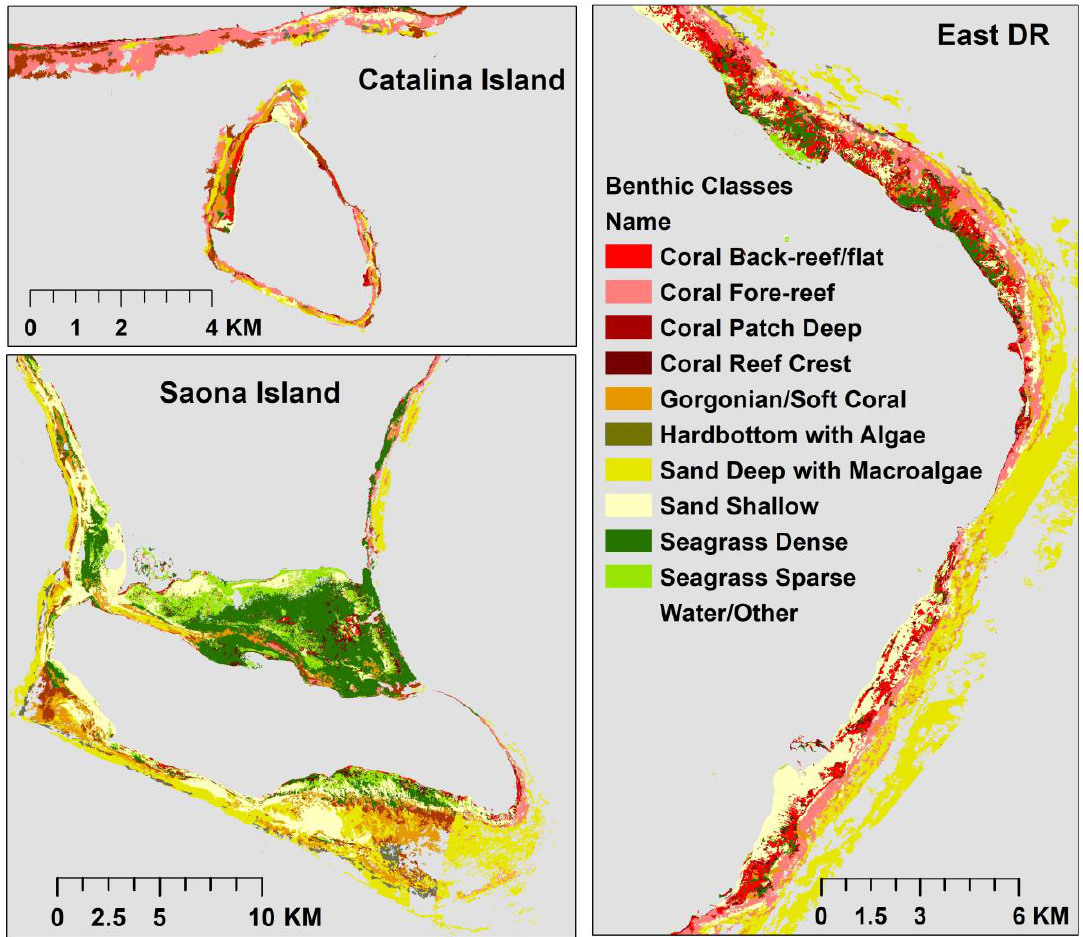
Figure 5. Benthic habitat classification results covering three study sites within the Arrecifes del Sureste marine sanctuary in southeastern Dominican Republic: Catalina Island, Saona Island, and eastern Dominican Republic.